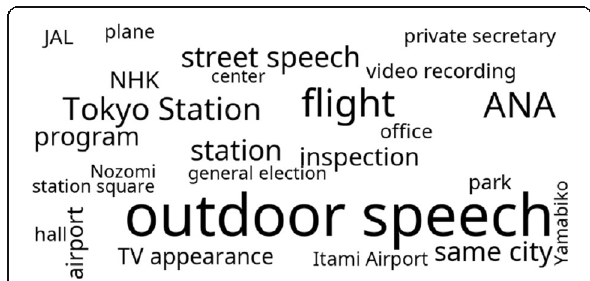
Fig. 6 Word cloud of election topic 1 (last-minute election campaign)